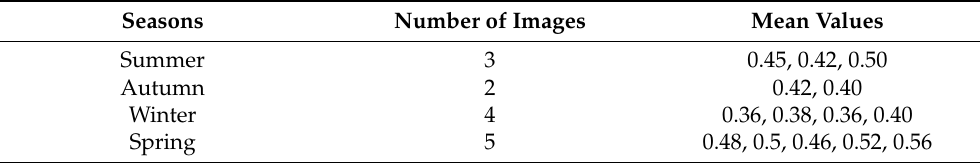
Table A1. The consistency check of K d derived from adjacent days in each season from 2020 to 2021.